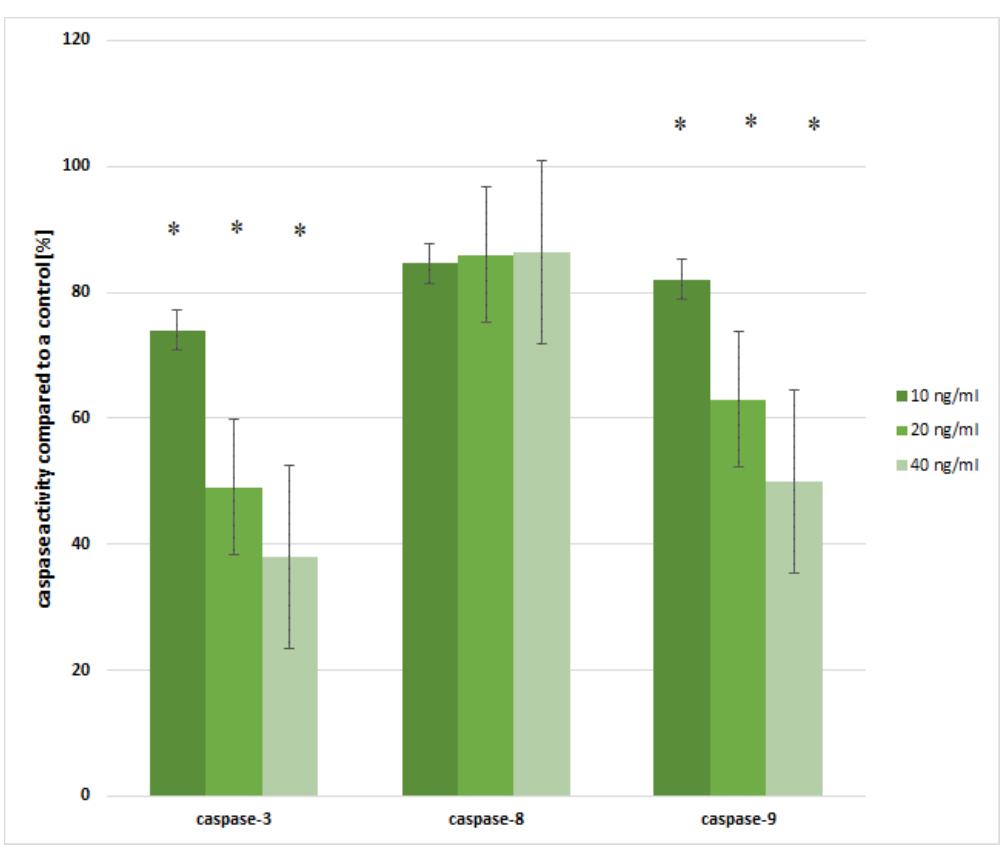
Figure 4. Caspase-3, -8 and- 9 activity in the Ishikawa cell line exposed to 10 ng/mL, 20 ng/mL and 480 ng/mL of leptin for 24 h (*—statistically significant differences in comparison to the control cell culture; p < 0.05; control: cells treated with PBS; 100%).